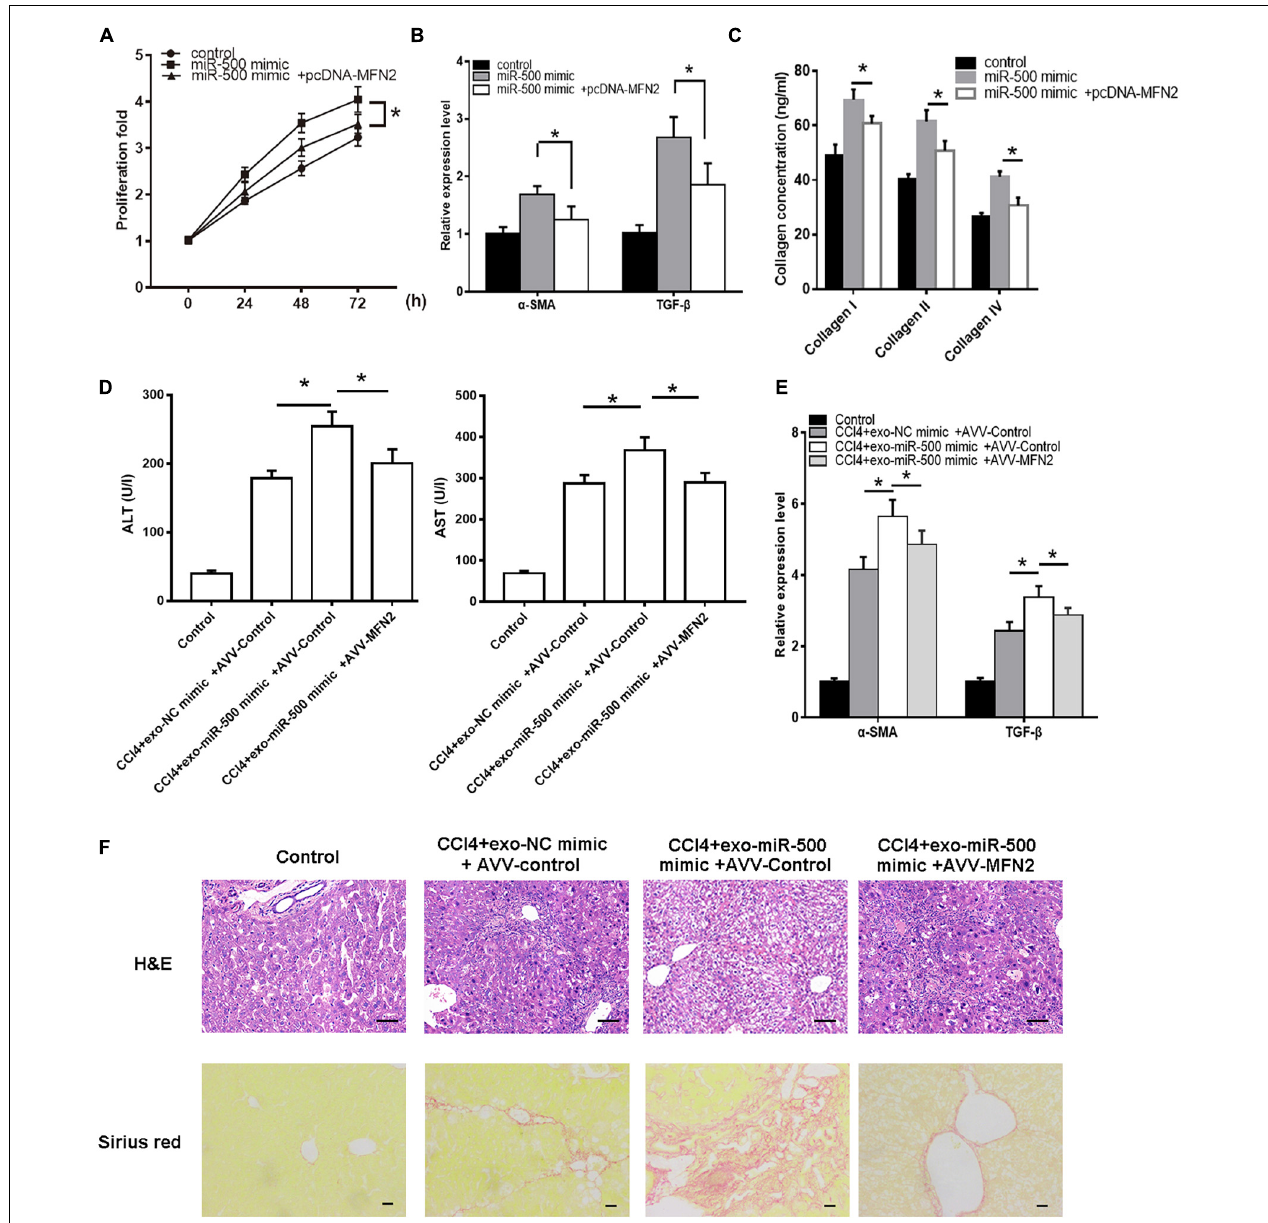
FIGURE 6 | MFN2 reverses the effect of exosomal miR-500 on liver fibrosis in vitro and in vivo . (A) HSCs with transfection of pcDNA-MFN2 or not were treated with exosomes derived from LPS-treated macrophages with or without miR-500 overexpression, and then cell proliferation was determined using CCK-8 assays. (B) HSCs with transfection of pcDNA-MFN2 or not were treated with exosomes derived from LPS-treated macrophages with or without miR-500 overexpression, and the expression of α -SMA and TGF- β was detected by using qRT-PCR. (C) HSCs with transfection of pcDNA-MFN2 or not were treated with exosomes derived from LPS-treated macrophages with or without miR-500 overexpression, and the concentrations of type I, III, and IV collagen in cell culture supernatants were measured by ELISA. (D) ALT and AST levels in mouse serum from Control, CCl 4 + exo-NC mimic+ AVV-Control, CCl 4 +exo-miR-500 mimic+ AVV-control, and CCl 4 +exo-miR-500 mimic+ AVV-MFN2 groups were determined. Mean ± SD. n = 8. (E) The expression of α -SMA and TGF- β in mouse liver from Control, CCl 4 + exo-NC mimic+ AVV-Control, CCl 4 +exo-miR-500 mimic+ AVV-control, and CCl 4 +exo-miR-500 mimic+ AVV-MFN2 groups were determined by qRT-PCR. (F) H&E and Sirius Red staining of mouse liver from Control, CCl 4 + exo-NC mimic+ AVV-Control, CCl 4 +exo-miR-500 mimic+ AVV-control, and CCl 4 +exo-miR-500 mimic+ AVV-MFN2 groups (magnification 100 × ). * P <